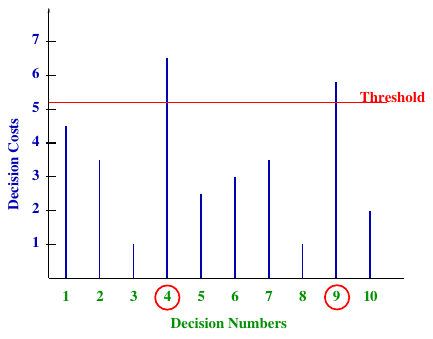
Figure 6. In this example ten decisions are considered and their costs are illustrated by the vertical bars for which the highest cost is 6.5. The threshold is then given by 6.5 × 0.8 = 5.2. The decisions with a cost higher than 5.2 are then selected to undergo the neighboring